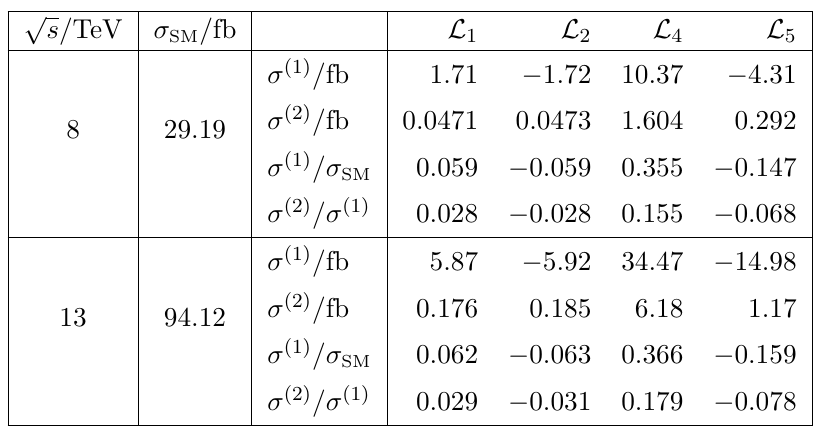
p p s = 8 TeV and s = 13 TeV